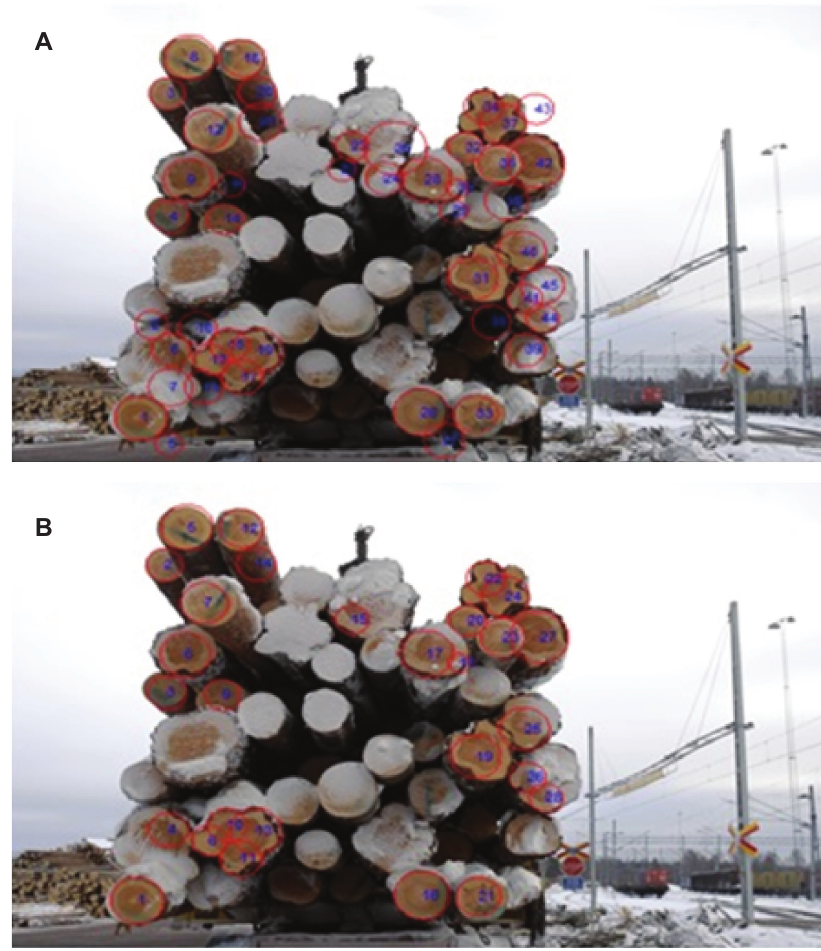
Figure 5. Image Where Log Detection Accuracy is < 70%.